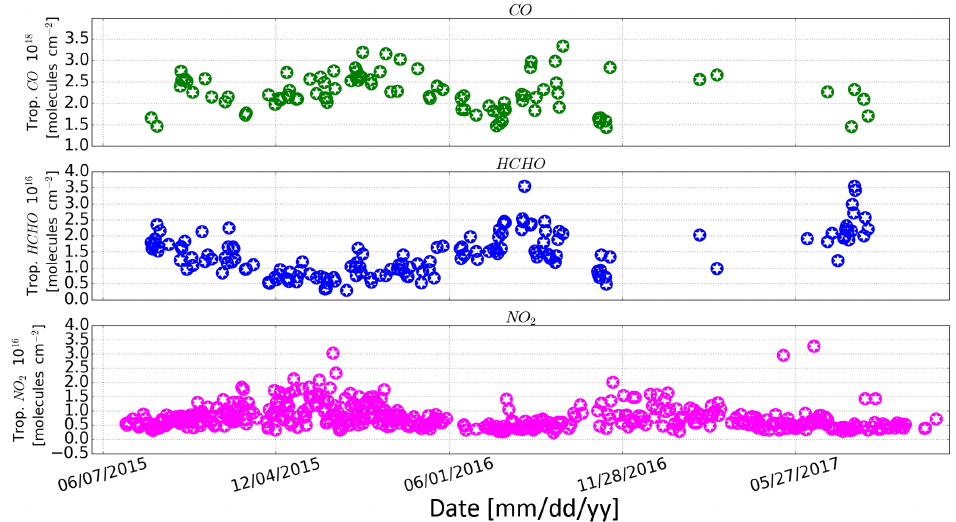
Figure 5. Time series of tropospheric CO, HCHO, and NO 2 . Tropospheric CO and HCHO were derived from FTS observations, which is the same as tropospheric O 3 , and tropospheric NO 2 is derived from OMI data.